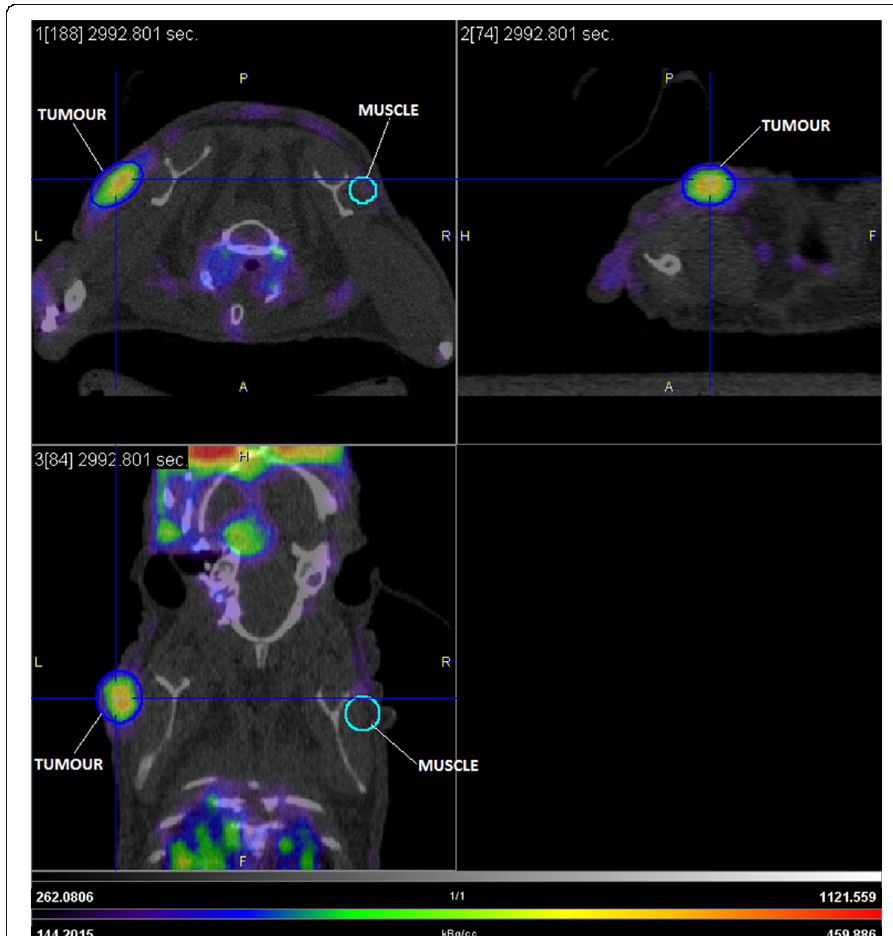
Fig. 6 Xenografic tumor mice (LNCaP cell, Nude N: NIH (S) – Foxn 1nu mice) image acquired after administration of of [18F]ALF, using a small animal tri-modality PET/SPECT/CT scanner (TriumphTM, TriFoil, Inc.,